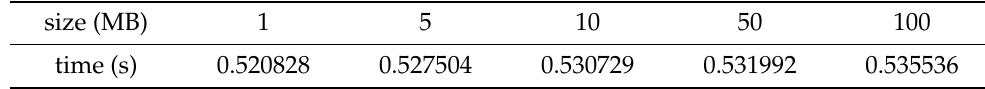
Table 2. The time needed for backing up the mappings.